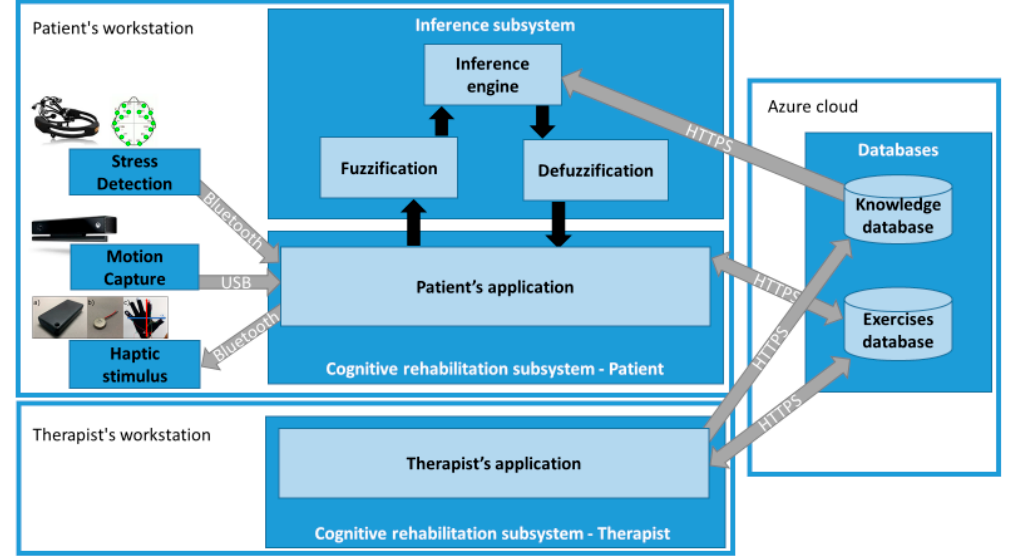
Figure 1. Architecture of the ambient intelligence environment for cognitive telerehabilitation.